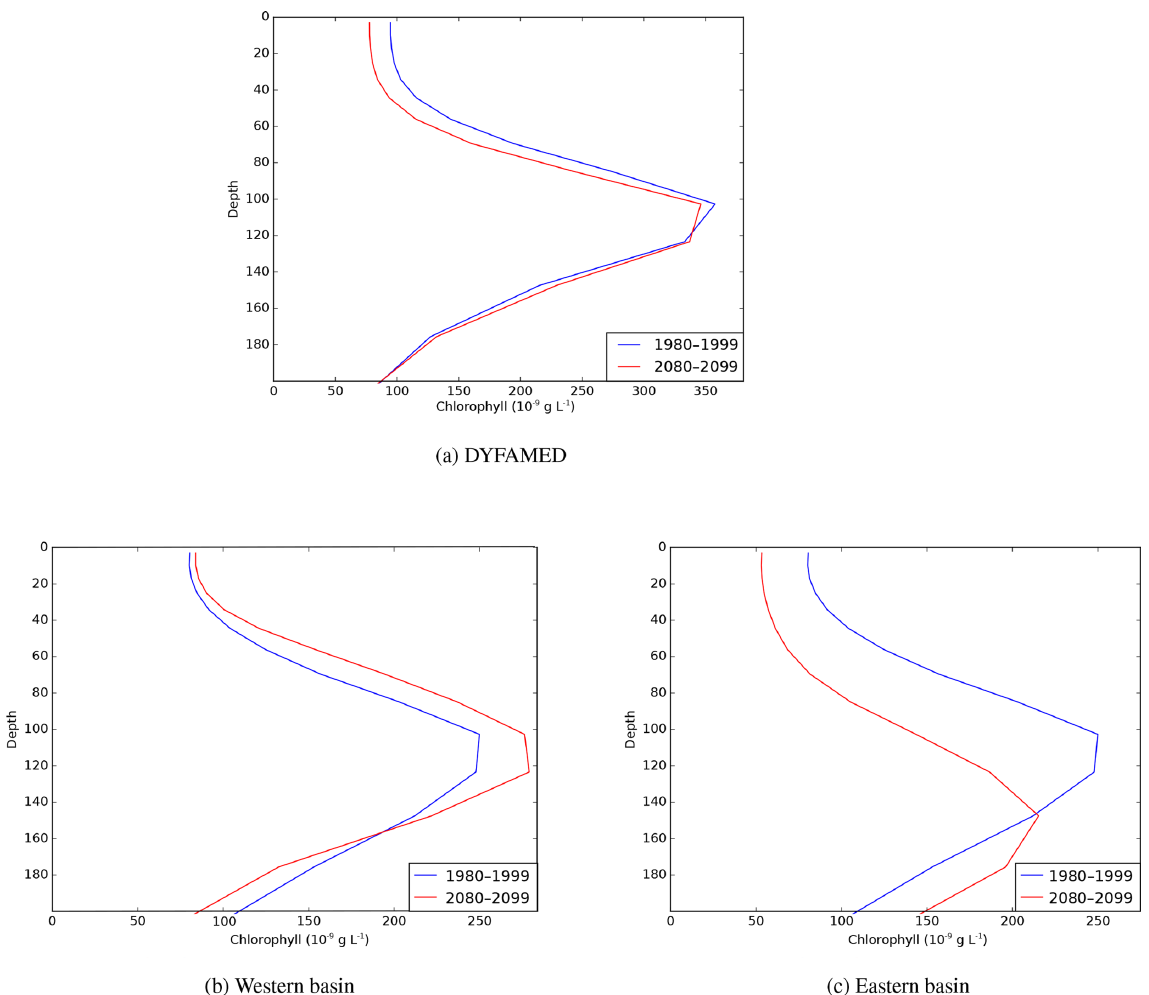
Figure 14. Present (1980–1999) and future (2080–2099) interannual average vertical profiles of total Chl a (ngL − 1 ) at the DYFAMED station, and averaged profiles over the western and eastern (including Aegean and Adriatic)